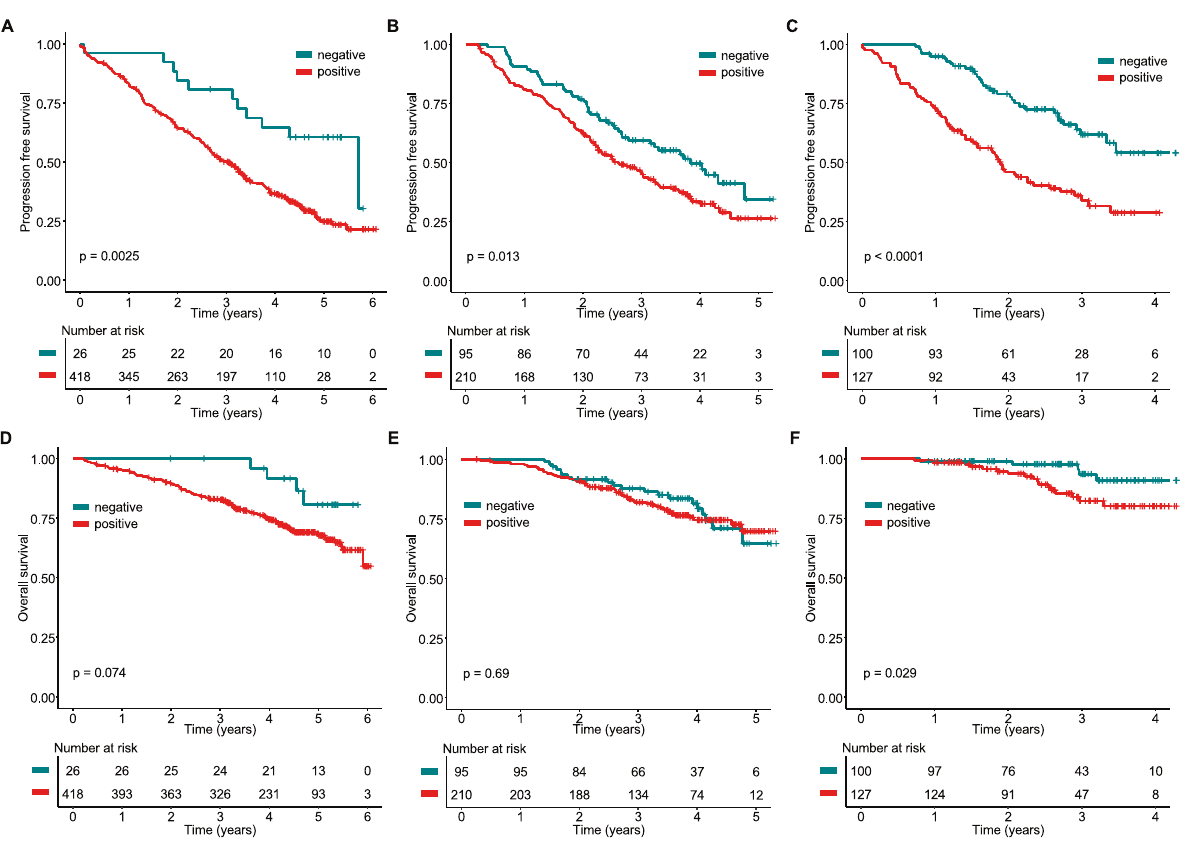
Fig. 2 Prognostic value of mass spectrometry at de fi ned time points. Progression-free (PFS) and overall survival (OS) of GMMG-MM5 patients strati fi ed by the mass spectrometry test result (negative/positive) after induction therapy ( A + B ), prior to maintenance therapy/ observation ( C + D ) and after one year of maintenance treatment/observation ( E + F ). PFS and OS times were measured from the respective